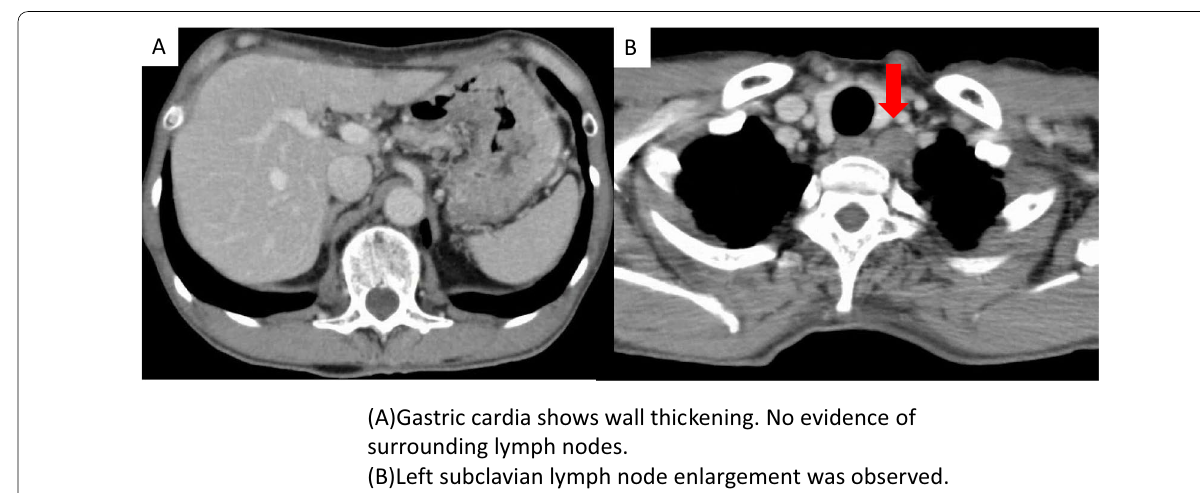
(A)Gastric cardia shows wall thickening. No evidence of surrounding lymph nodes. (B)Left subclavian lymph node enlargement was